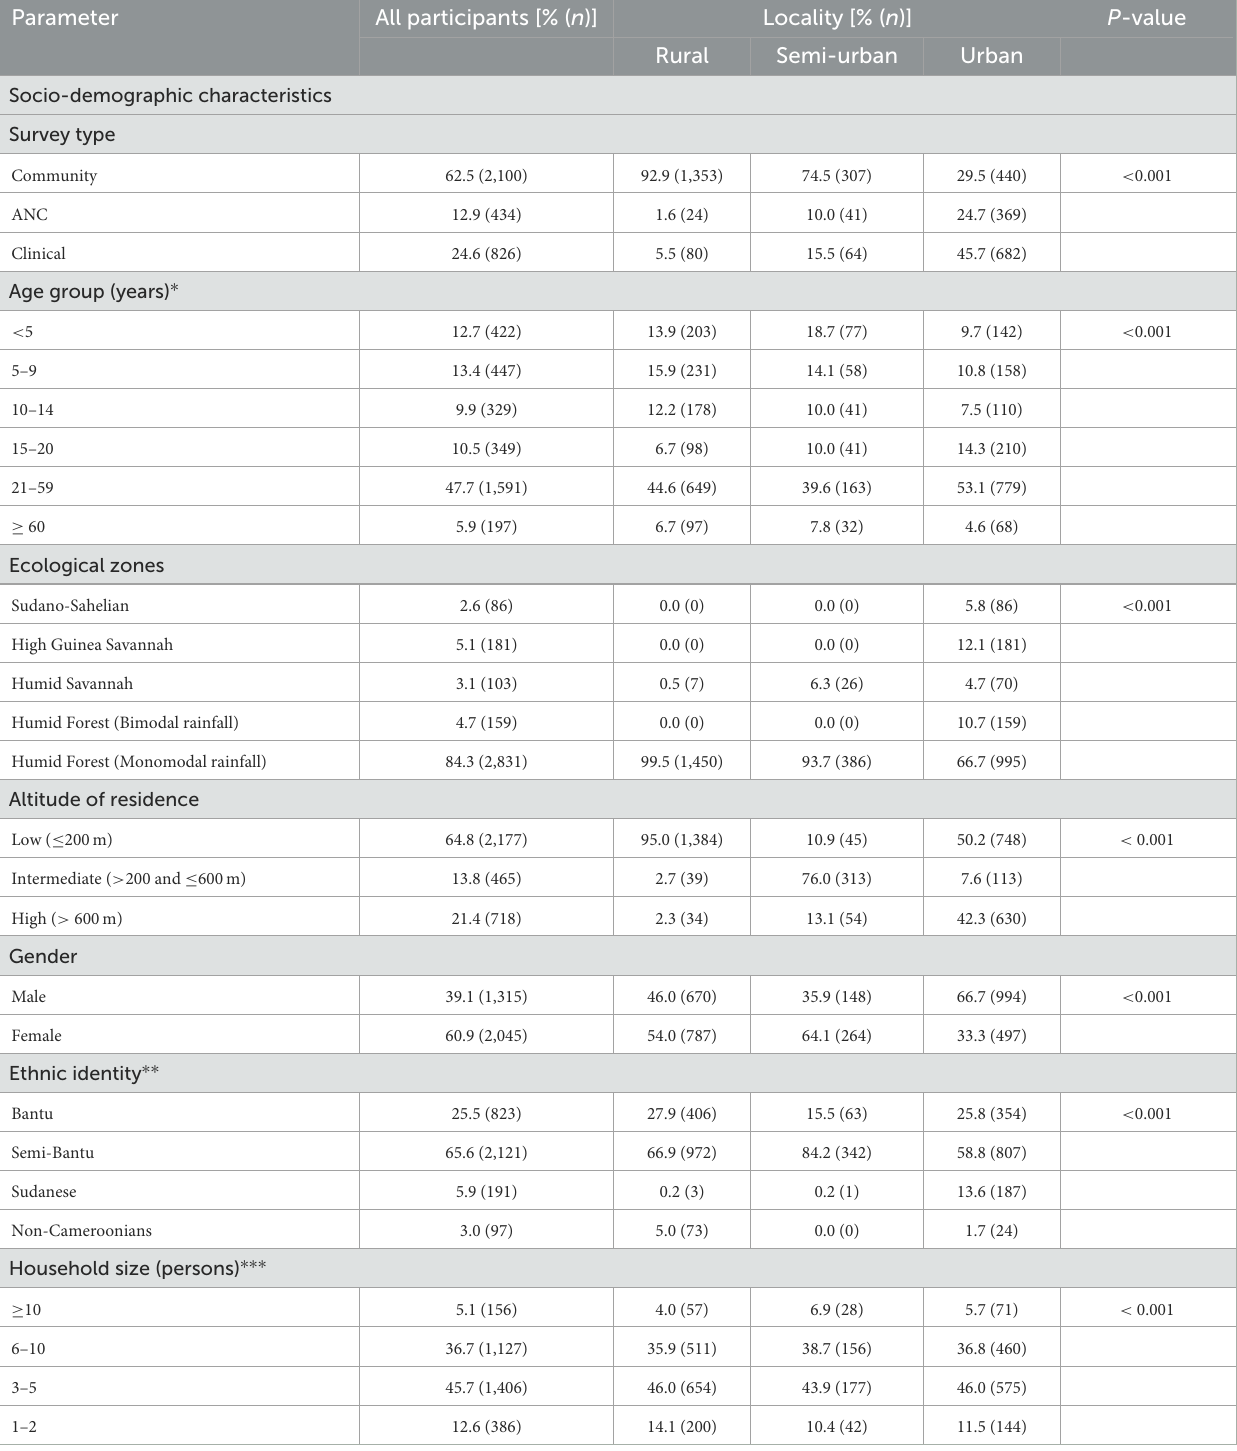
TABLE 2 Socio-demographic characteristics of the study population ( n = 3,360). Parameter All participants [% ( n